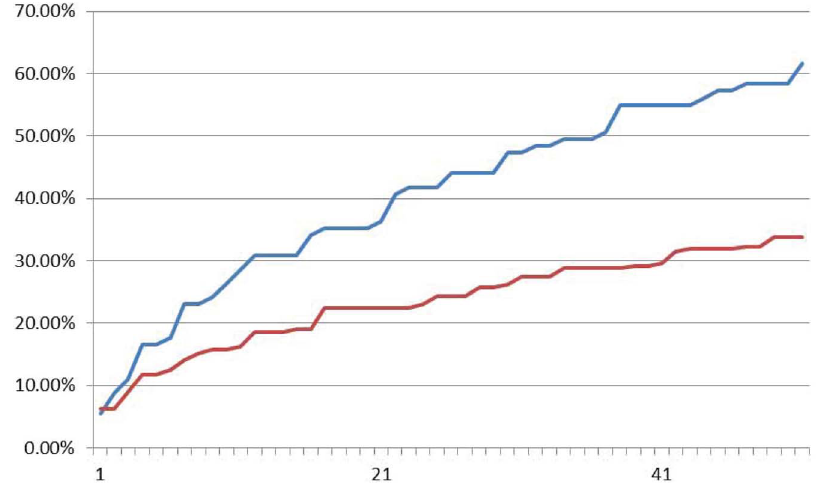
Figure 14. Fluoroscence data of DNA Neurons execute AND logic with input ‘‘01’’. The X-axis is cycling time of Real-time PCR, the time span of each cycle is 10 minutes, temperature of each cycle keeps in 24–25 u C. The Y-axis is relative intensity of HEX (red curve) and FAM (blue